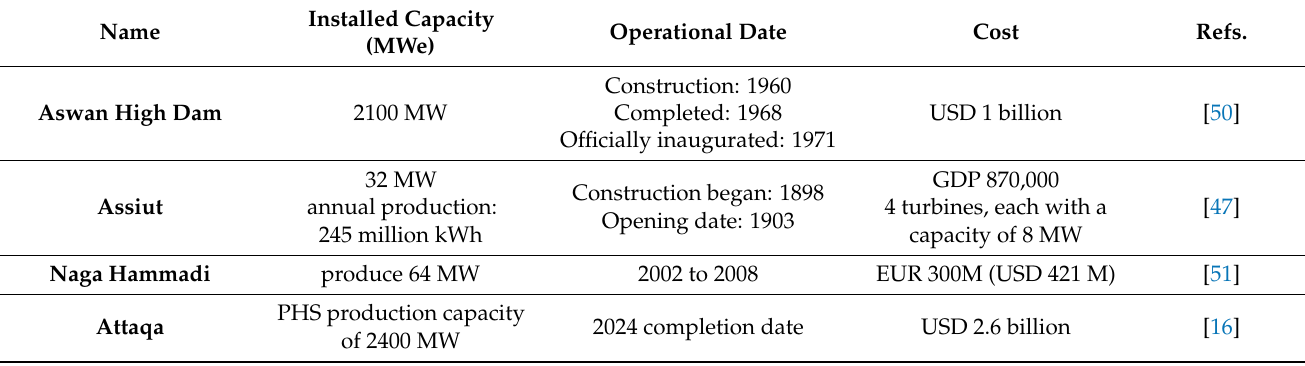
Table 6. Egypt hydropower plants.